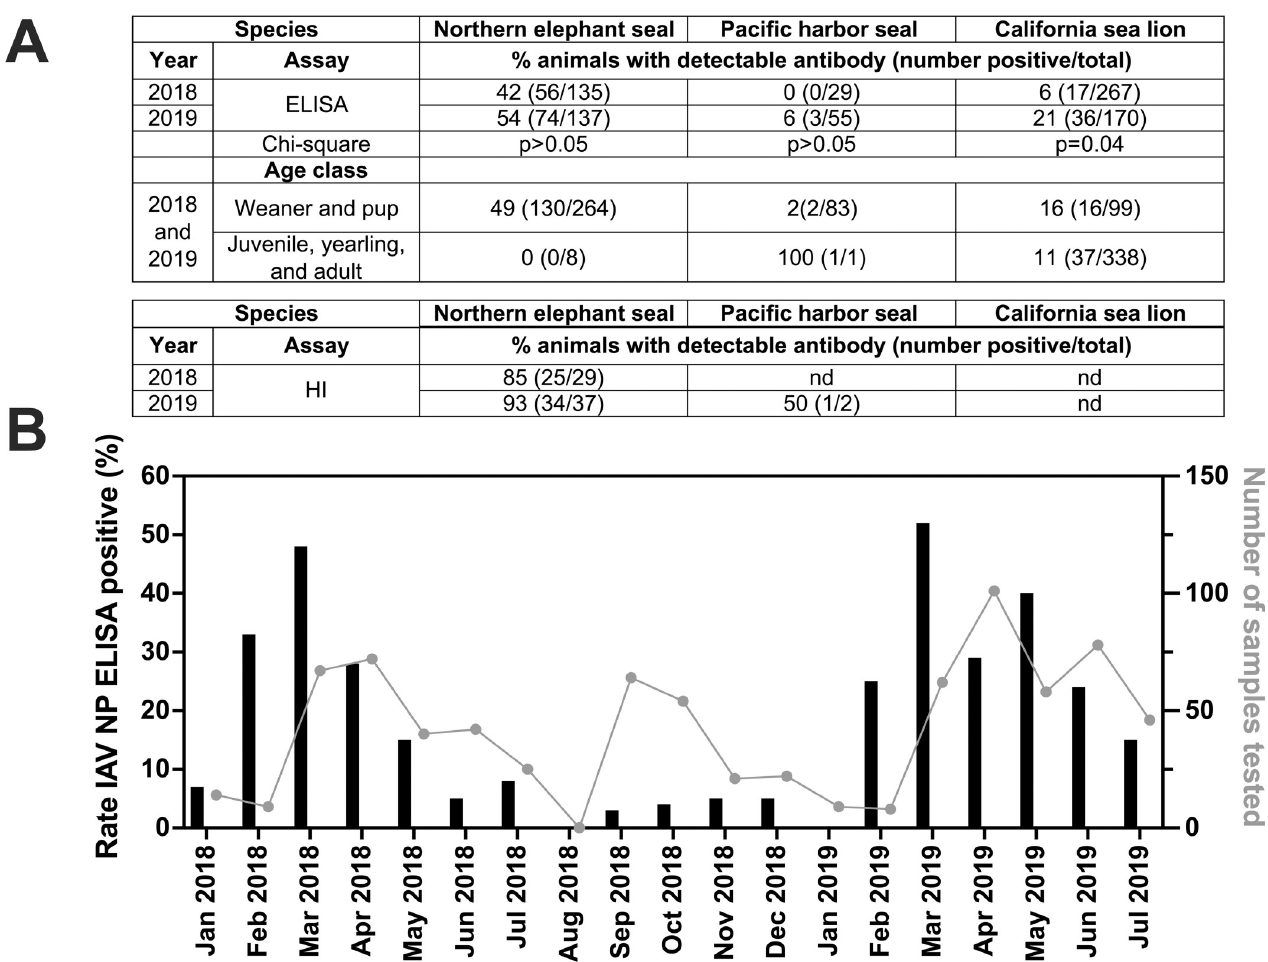
Fig 1. Influenza A virus antibody detections in marine mammals, California, 2018–2019. A ) Rates of IAV nucleoprotein (NP) enzyme-linked immunosorbent assay (ELISA) and H1N1 hemagglutination inhibition (HI) reactivity in marine mammal sera from January 2018 to July 2019. ELISA antibody detections by age class of marine mammals are also shown. nd indicates not done. B) IAV NP ELISA seroprevalence by month for the study